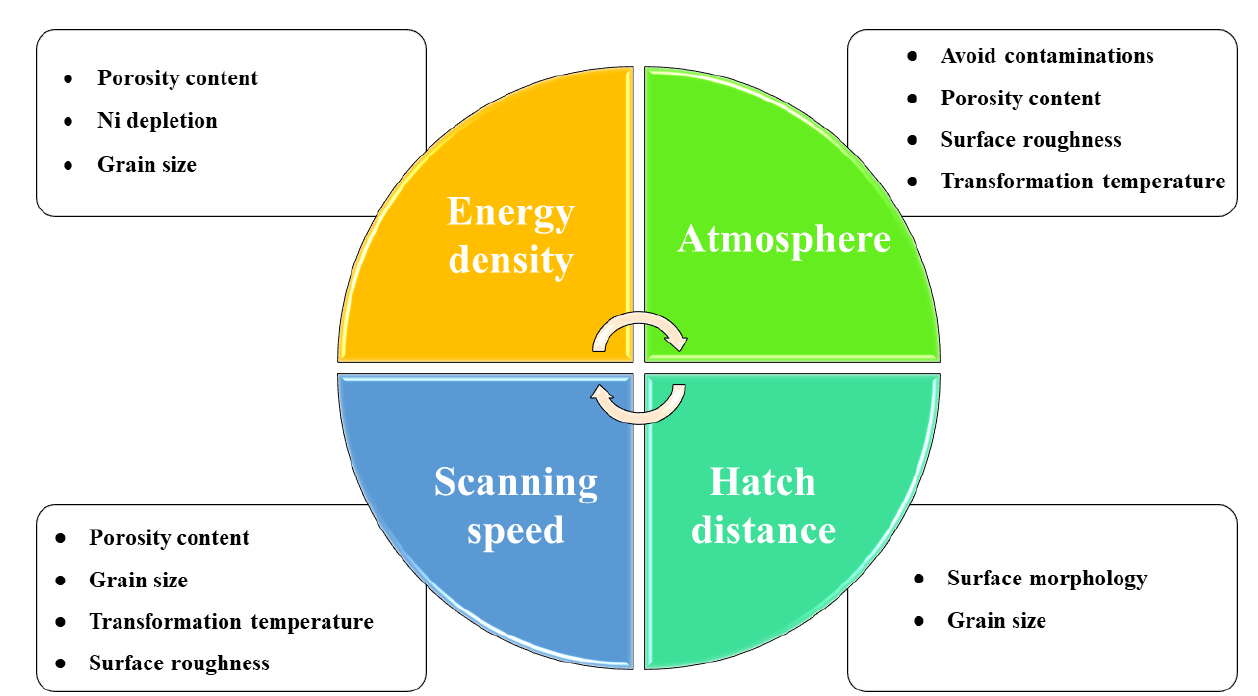
Figure 4. Schematic illustration of the relationship between the important parameters involved in the LPBF process and the physical properties of AM-fabricated NiTi.